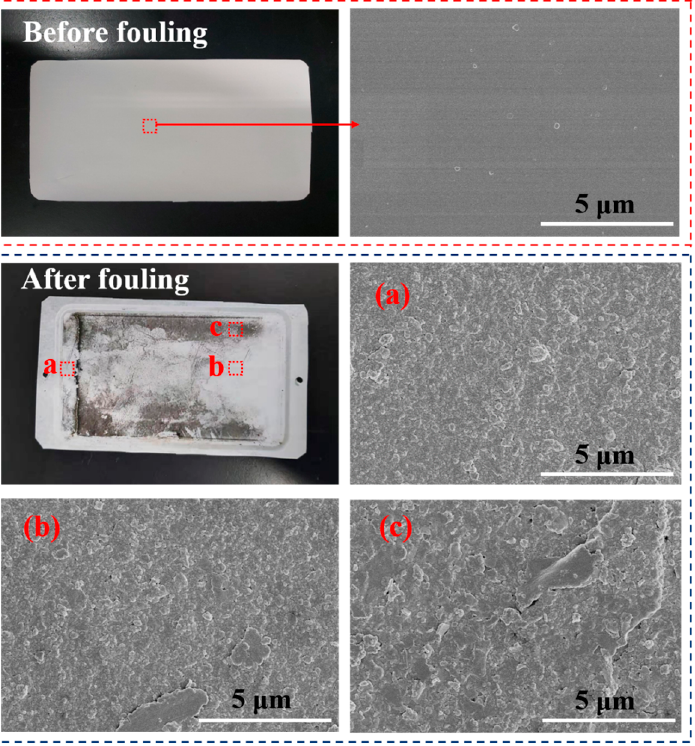
Figure 6. Photographs and SEM images of the membrane before and after fouling by simulated secondary treated sewage (SSTS: 200 ppm HA, pH = 7; TMP = 0.5 MPa).